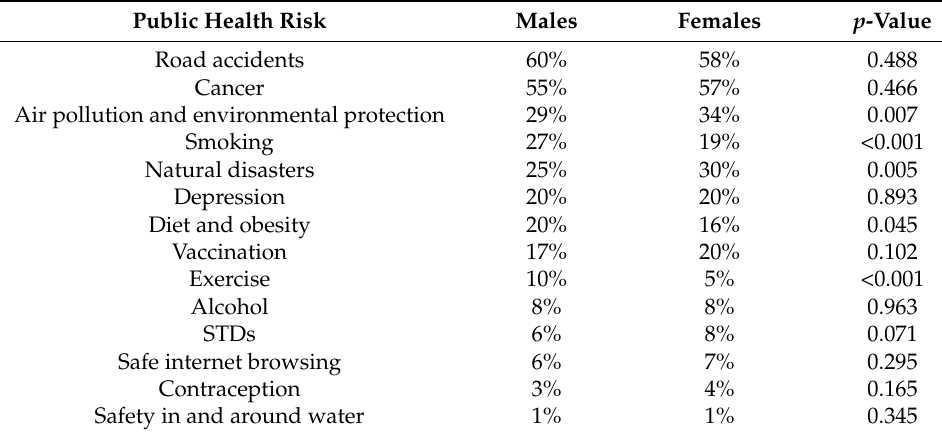
Table 3. Most Important public health risk by sex.